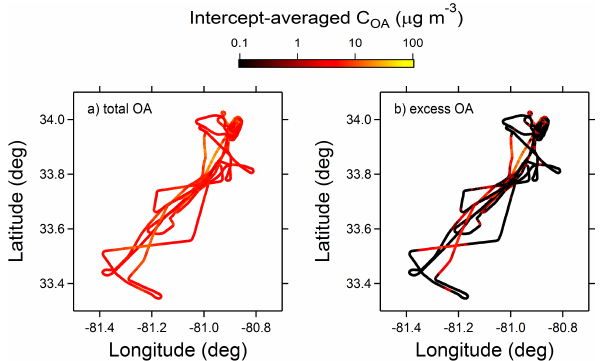
Figure 1. Flight tracks colored by (a) total OA concentration and (b) excess OA concentration. Due to the log scaling of intercept-averaged concentrations, the minimum value in (b) is set to 0.1µgm − 3 . Removing the background OA elucidates distinct plume transport to the